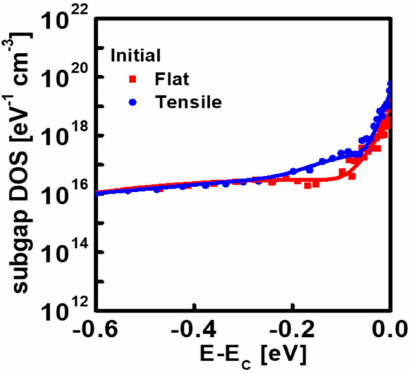
Figure 5. Energy distribution of the subgap density of states (DOS) obtained from the IGZO TFTs before positive-bias-stress (PBS) application under the tensile bending stress and no mechanical stress.